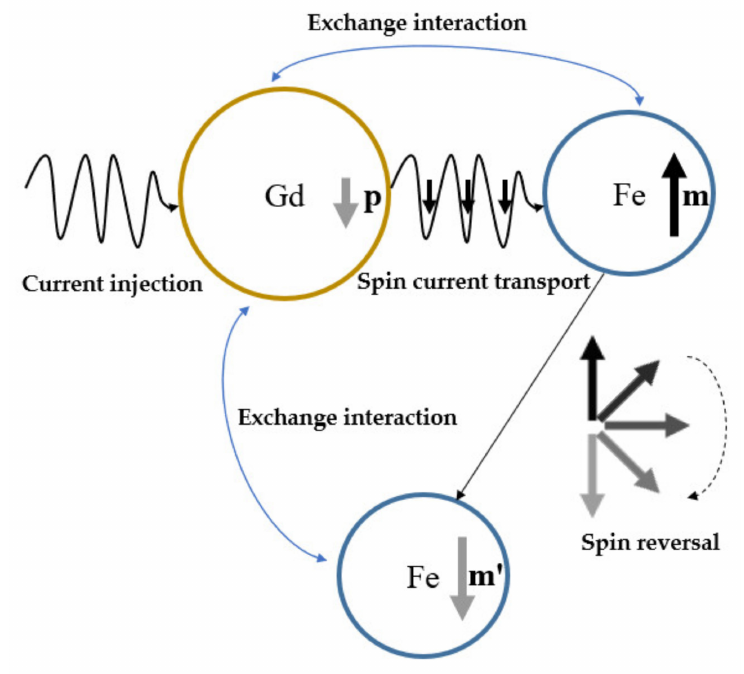
Figure 2. Spin current conduction in a GdFe